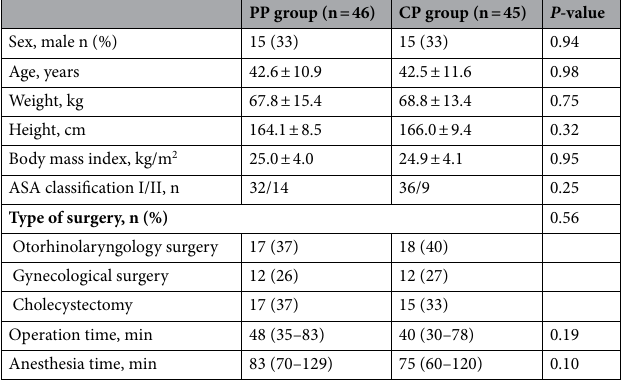
Table 1. Patients’ demographics and details related to surgery. ASA American society of anesthesiologists. Continuous variables are presented as mean ± SD or median (25th to 75th quartile). Nominal variables are presented number (frequency).